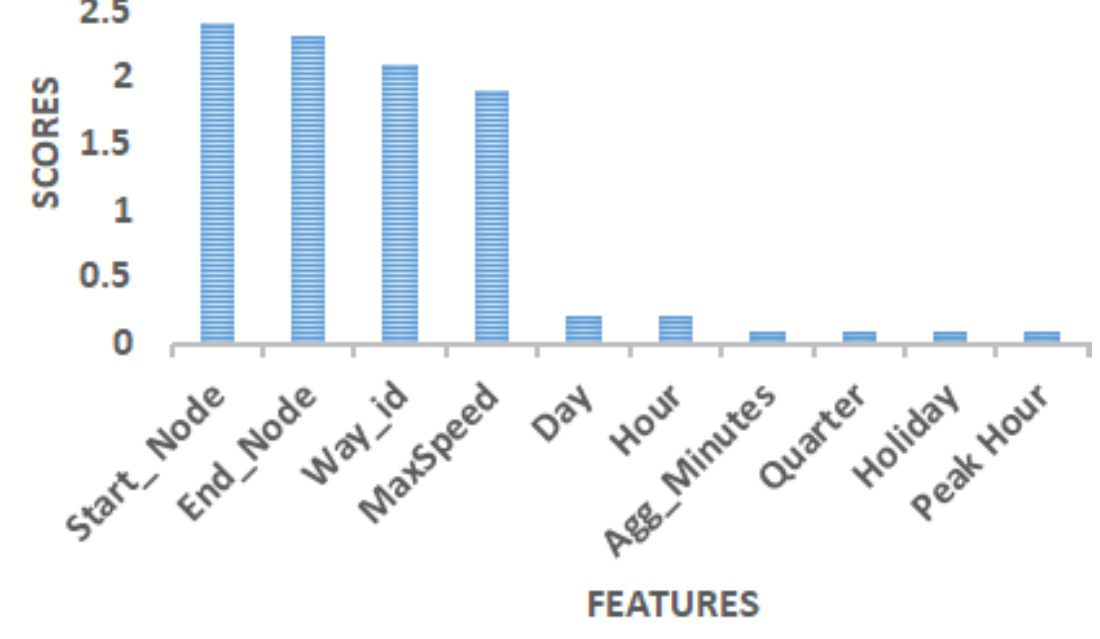
Figure 4. Feature selection using mutual information regression feature selection